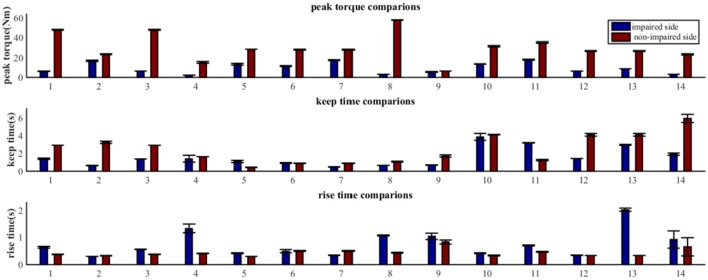
Comparative analysis of MIVC features between the impaired and non-impaired arms across all the 14 recruited subjects (Mean ± SEM).